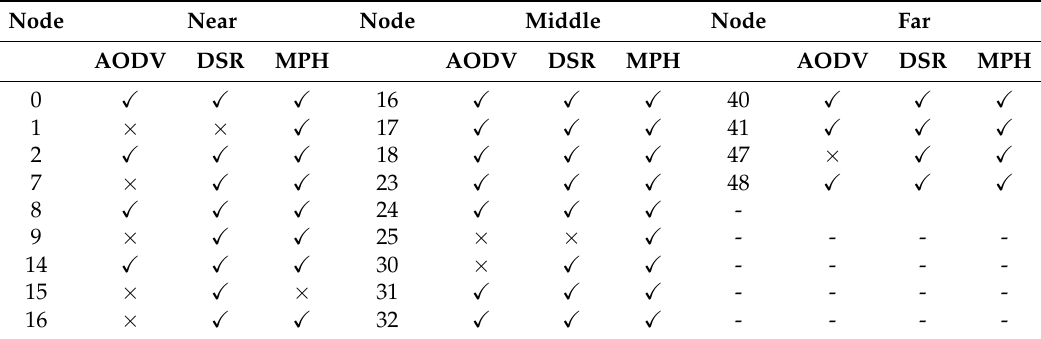
Table 3. Results of the jamming detector for the nodes under